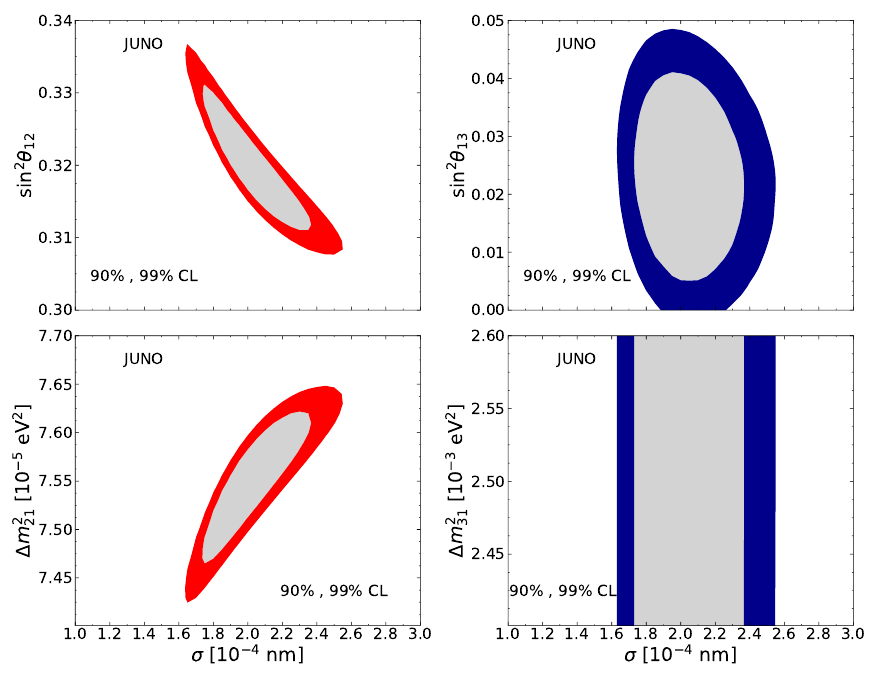
Figure 7 . 90 and 99% CL (2 d.o.f.) allowed regions in the (cid:27) -sin 2 (cid:18) 12 (top,left), (cid:27) -(cid:1) m 2 tom,left), (cid:27) -sin 2 (cid:18) 13 (top,right), and (cid:27) -(cid:1) m 2 lated JUNO data consistent with strong decoherence ( (cid:27) = 2 : 01 (cid:2) 10 (cid:0) 4 nm). The input values for the standard solar oscillation parameters are listed in eqs. (2.5) while (cid:1) m 2 sin 2 (cid:18) 13 = 0 : 0231. See text for